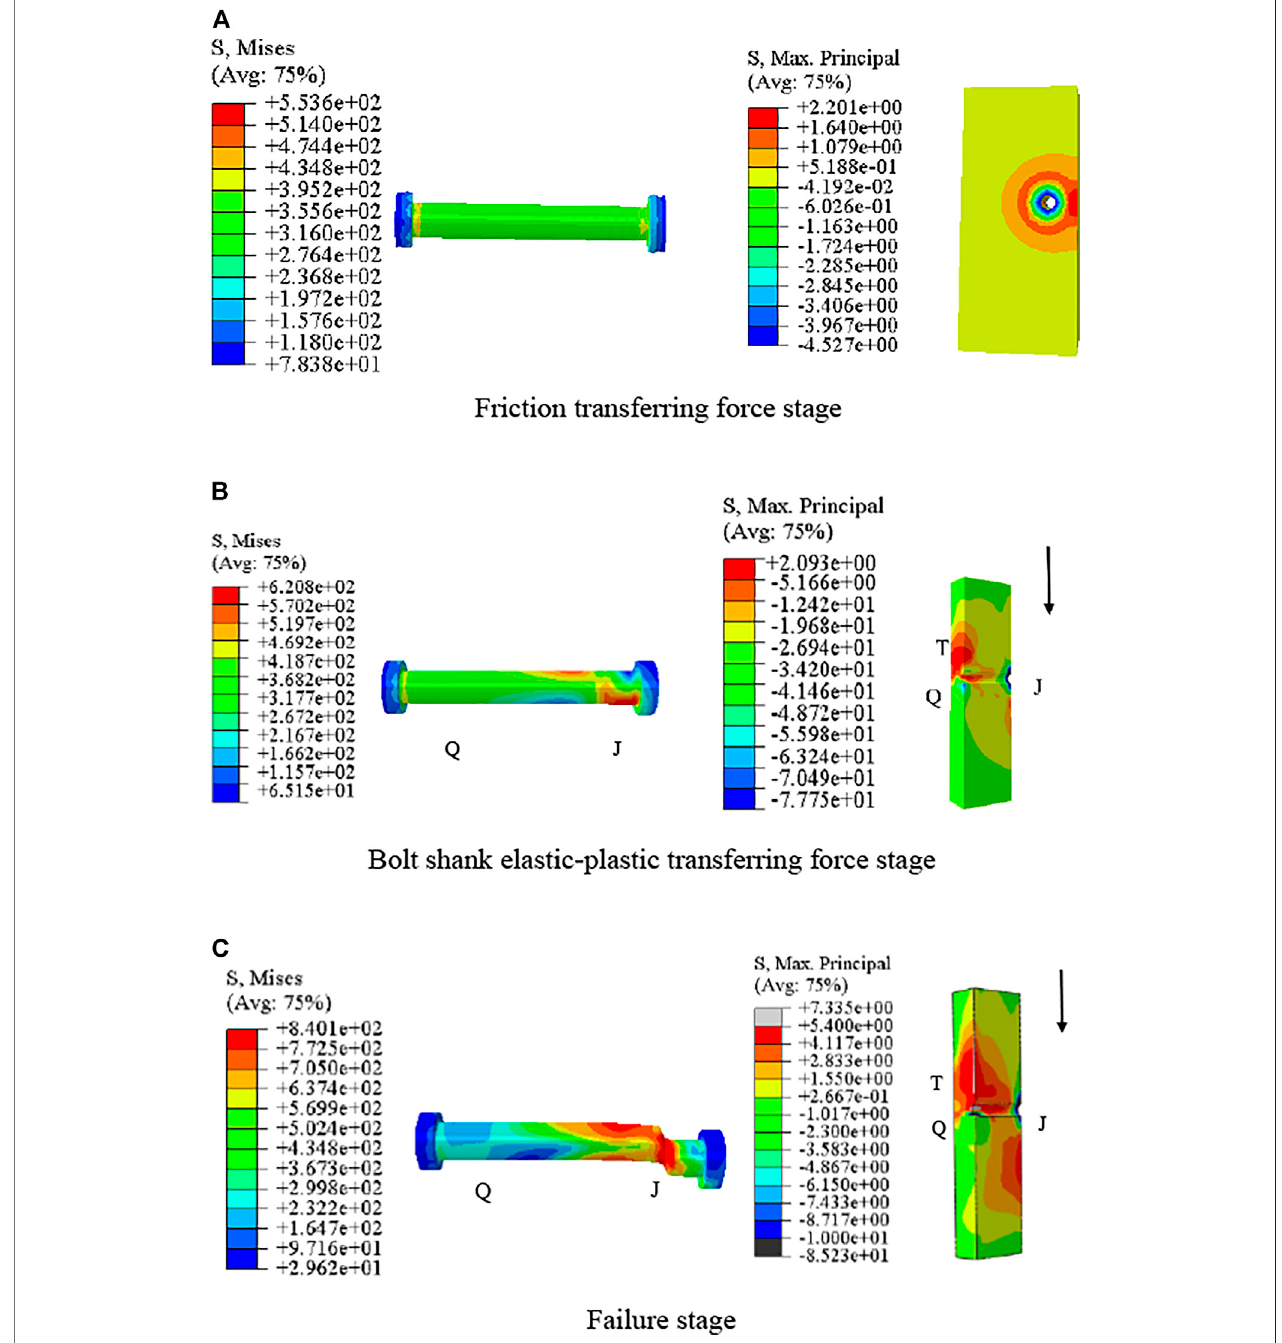
FIGURE 11 | Stress distribution in HSFGBs and concrete slabs in SFRC-22- α 1-8.8 specimen(MPa).